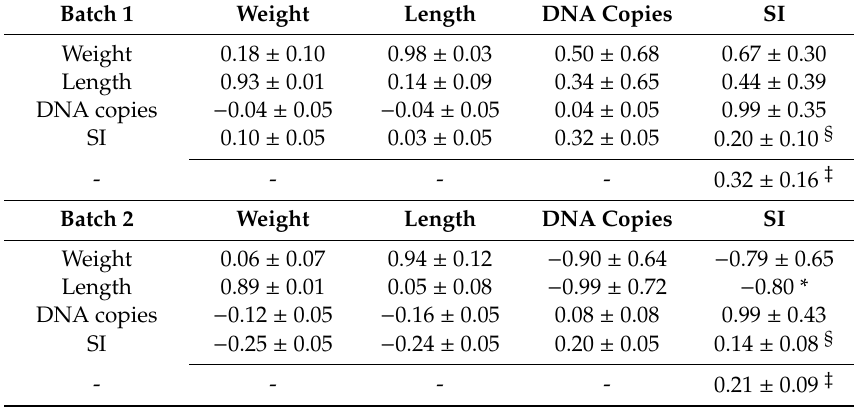
Table 1. Heritabilities (in bold) and the phenotypic (below the diagonal) and genetic correlations (above the diagonal). Means ± standard deviations (SD) are indicated for body weight, fork length, LCDV DNA copies and SI in binary scale (SI).